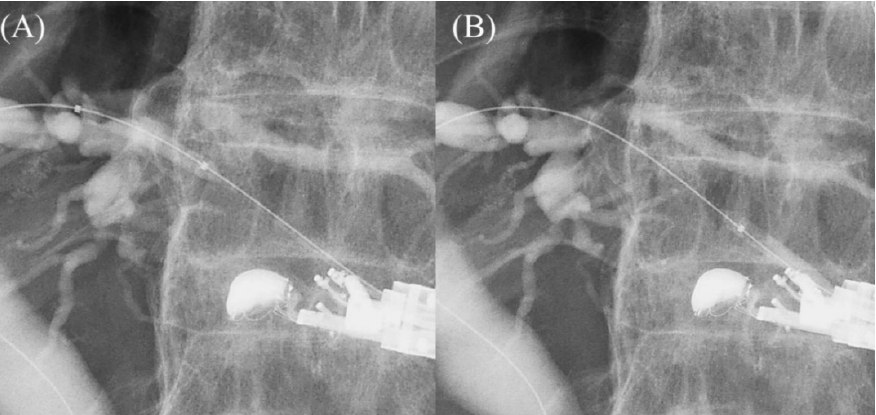
Figure 15. Segmental dilation method for prevention of bile leak during balloon dilation. A balloon catheter is pushed into the bile duct as deeply as possible when dilating the bile duct wall ( A ) and pulled into the scope channel as long as possible when dilating the gastric wall to prevent overlap of the two dilated areas ( B ). The hepatic parenchyma left un-dilated is thought to prevent bile leakage due to the tamponade